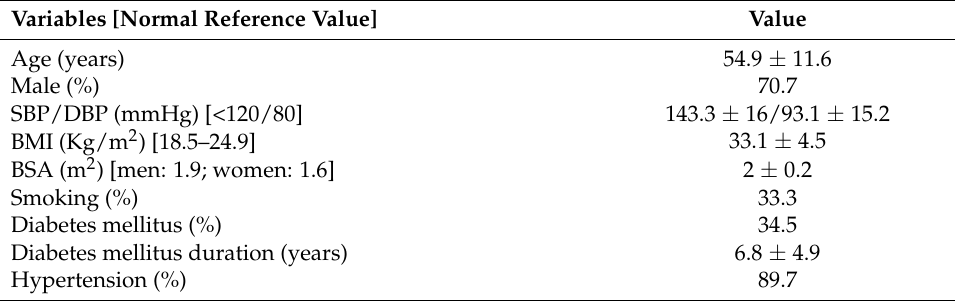
Table 1. Demographic characteristics and clinical